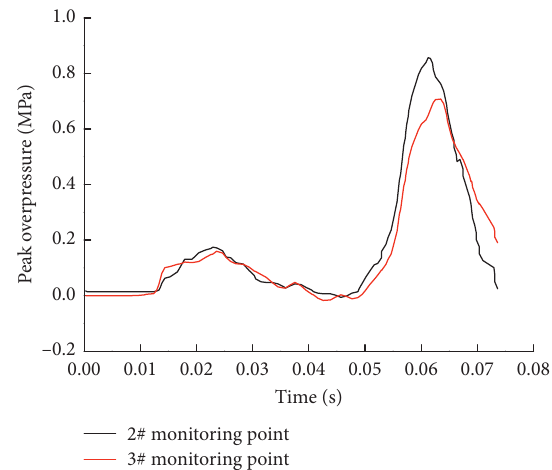
Figure 4: Shock wave pressure time travel